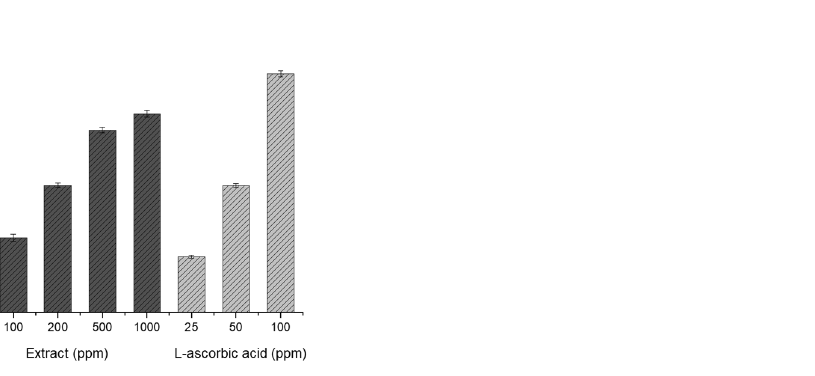
Figure 4. DPPH radical scavenging activity of PUL extract under optimal extraction conditions.